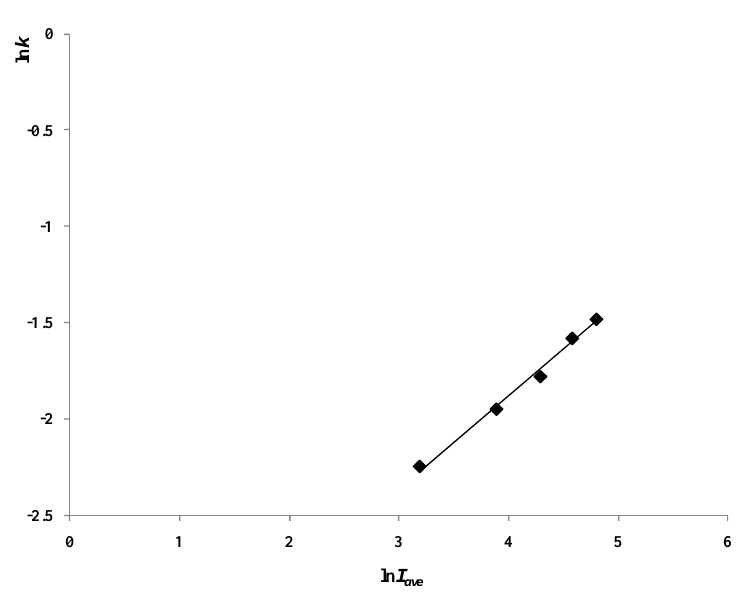
Figure 5 indicates that there is a linear relationship between ln k and ln I ( R 2 =